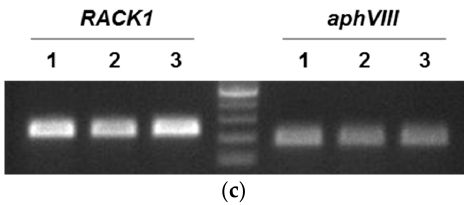
Figure 3. Validation of CvpsaD promoter functionality by expression of aphVIII . ( a ) Vector map of promoter cassette conjugated with resistance gene for verification of functionality. The CrepsaD promoter cassette serves as a positive control in Chlamydomonas . ( b ) The presence of aphVIII was confirmed in putative transformants by polymerase chain reaction (PCR) analysis with 400 bp primer sets. Lane 1: wild type, Lane 2–4: pCrepsaD :: aphVIII , Lane 5–7: pCvpsaD :: aphVIII , Lane 8: plasmid